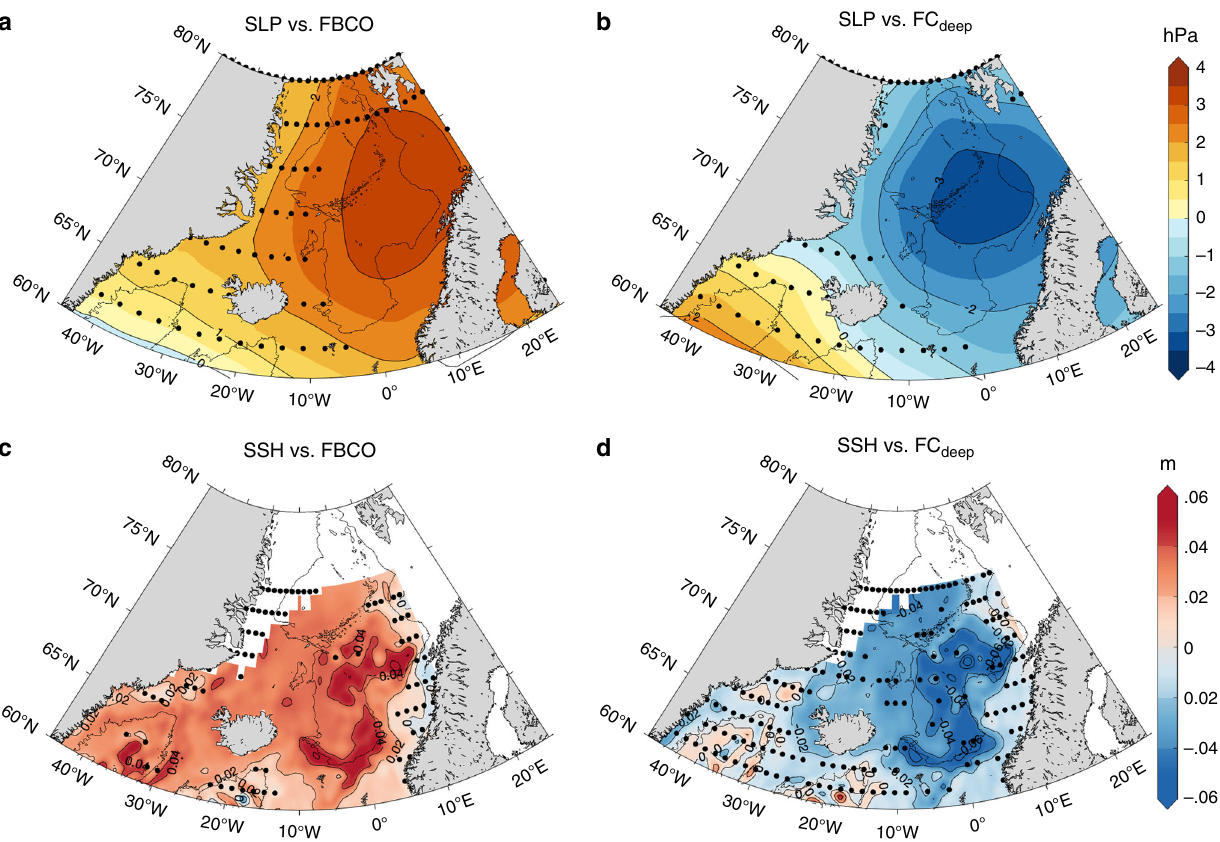
Fig. 3 Large-scale fi ngerprints of the deep fl ows. Composite difference analysis of sea-level pressure (SLP; a , b ) and sea-surface heights (SSH; c , d ) derived from satellite altimetry. The analysis is based on the difference between periods when the Faroe Bank Channel over fl ow (FBCO, left) and Faroe Current deep FC deep , right) time series are larger and smaller than one standard deviation. The data have been detrended and smoothed with a 360-day running mean before the analysis. The spatial patterns point to the close anti-phase relationship between the FBCO and FC deep . The SLP spatial patterns show that anticyclonic atmospheric circulation anomalies over the Nordic Seas lead to stronger FBCO and weaker eastward directed FC deep , and vice versa. The SSH spatial patterns highlight that the importance of the wind-driven barotropic fl ow along closed f / H ( f is the Coriolis parameter and H is depth) contours in the Nordic Seas. The gray line depicts the 2000 m isobath. White is missing